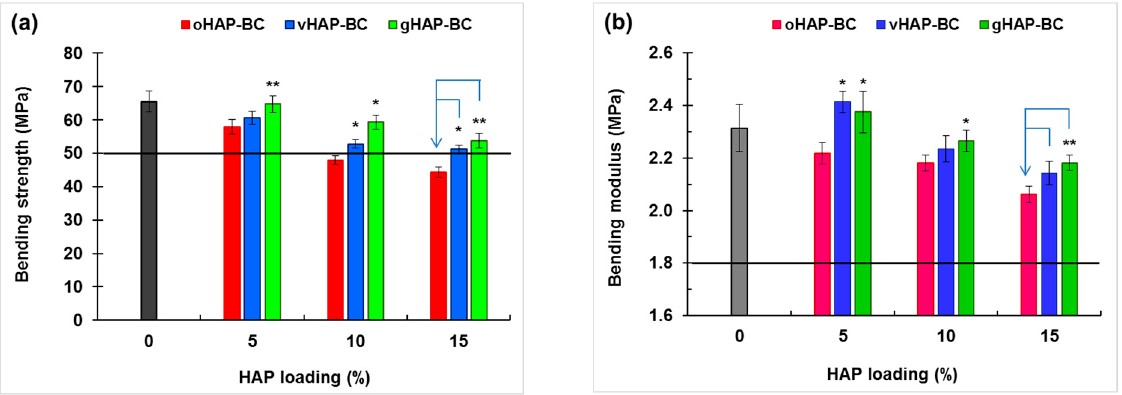
Figure 11. Bending properties of HAP-modified bone cements as function of HAP loadings. ( a ): bending strength and ( b ):